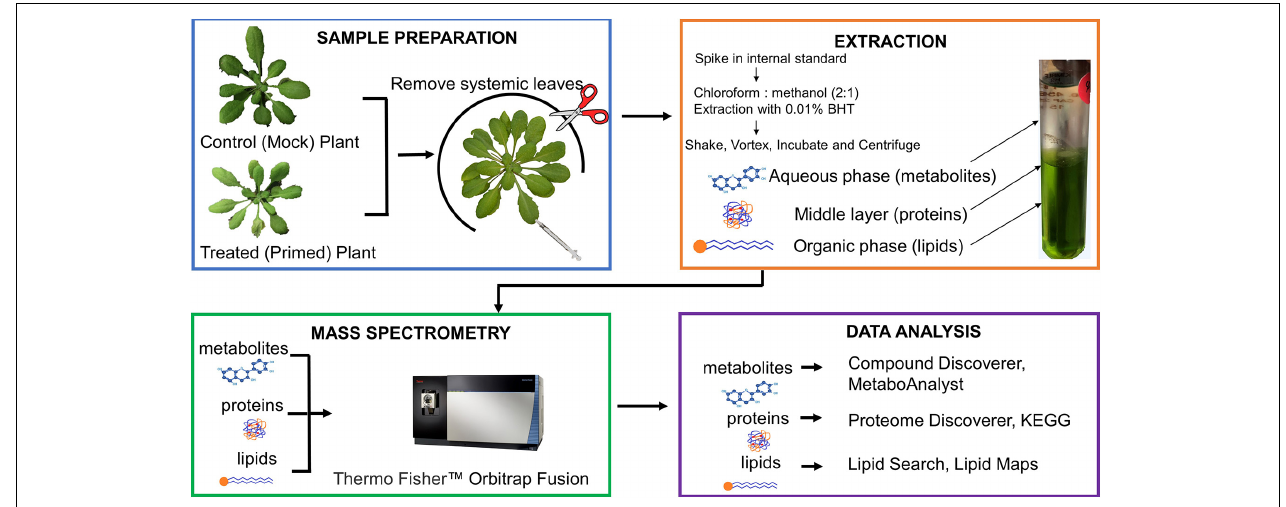
FIGURE 1 | Diagram of 3-in-1 sample preparation method for profiling proteins, metabolites, and lipids from control and primed Arabidopsis leaves. The biphasic fractionation separates three types of biomolecules simultaneously, which are analyzed on the same mass spectrometry platform. The data are also analyzed using the same vendor’s software. A more detailed workflow of the extraction is shown in Figure 2 .